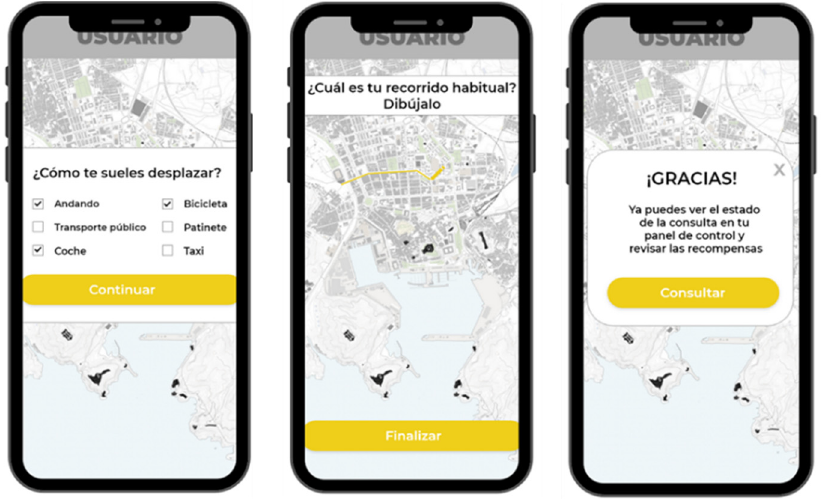
Figure 2. Apps with georeferenced information used for the development of surveys in Cartagena.